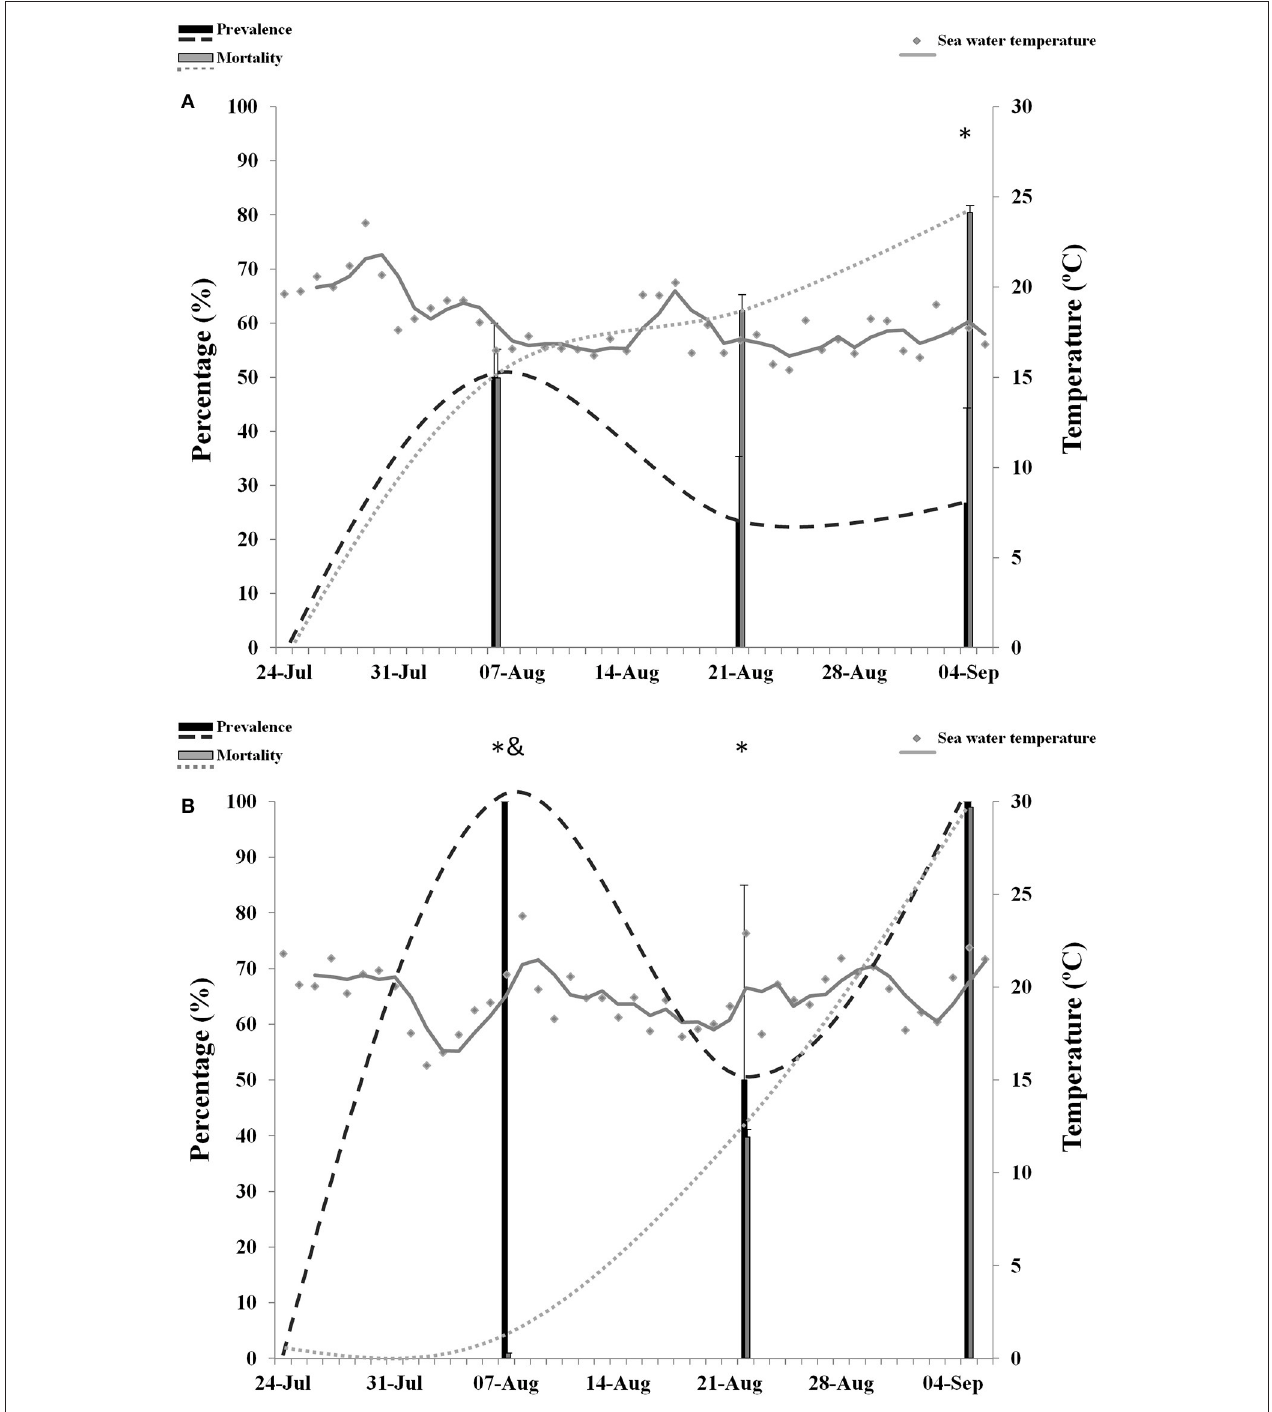
FIGURE 4 | Percentage of mortality and prevalence of OsHV-1 in spat collected from Site B (A) and Site C (B) . Maximum sea water temperature on each site is represented with gray dots and gray trend line. Asterisks and ampersand show significantly higher mortality and prevalence, respectively ( n = 3, p ≤ 0.05).